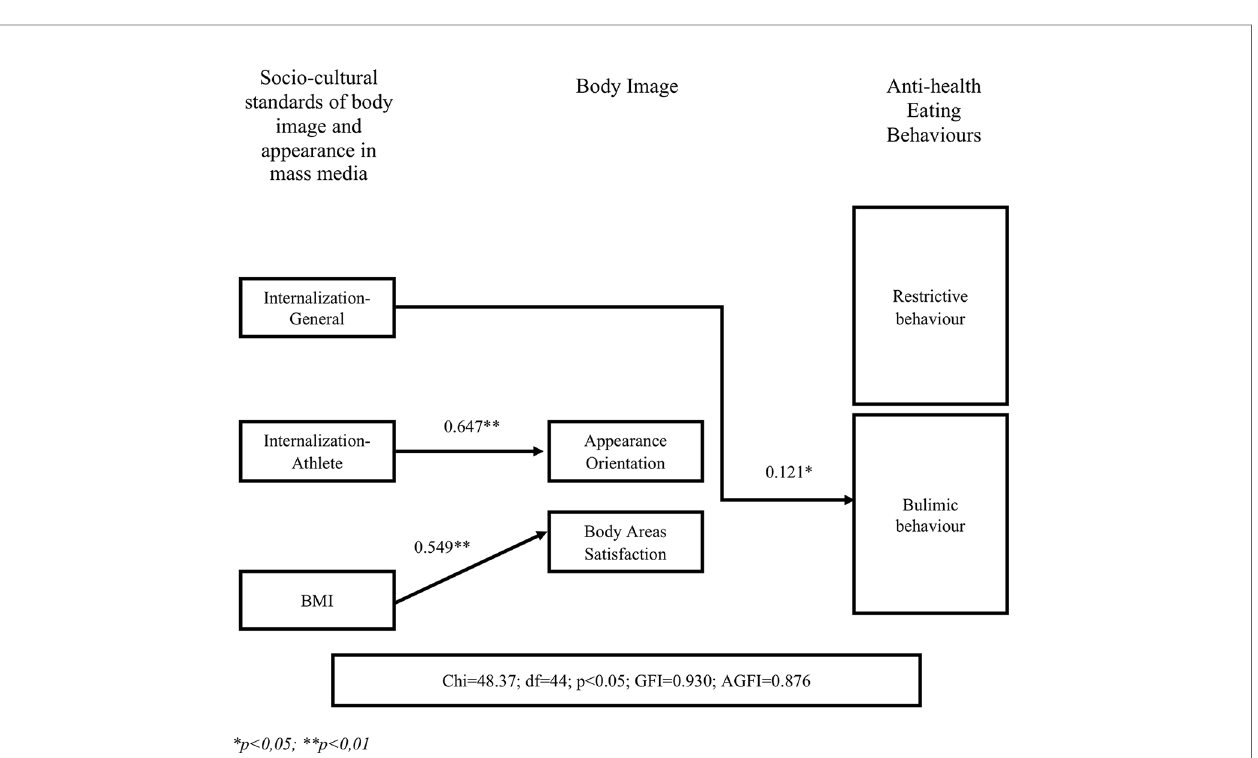
FIGURE 3 | Analysis of path model for studied variables in a group of